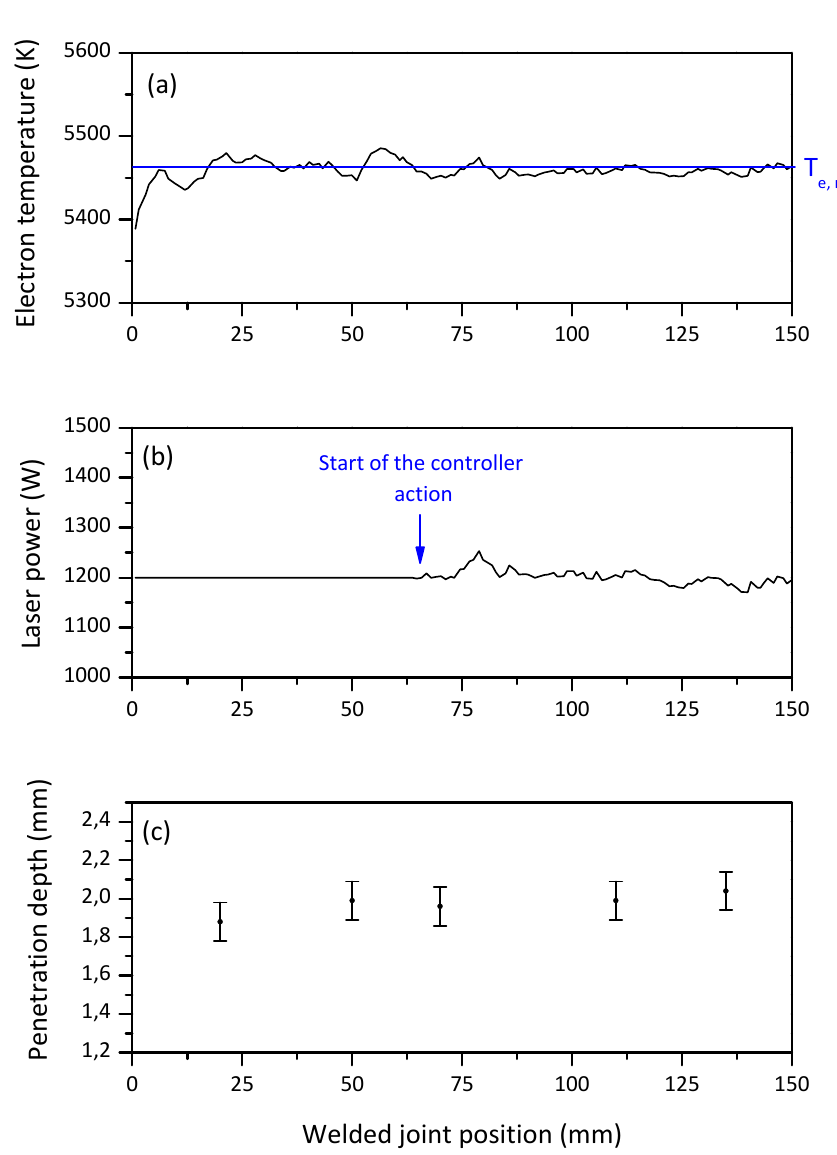
Figure 4. ( a ) Electron temperature signal behavior. Controller parameters: T corresponding to a penetration depth of 2 mm; K power = 1,200 W. ( b ) Laser power measured by fast power sensor. ( c ) Penetration depth